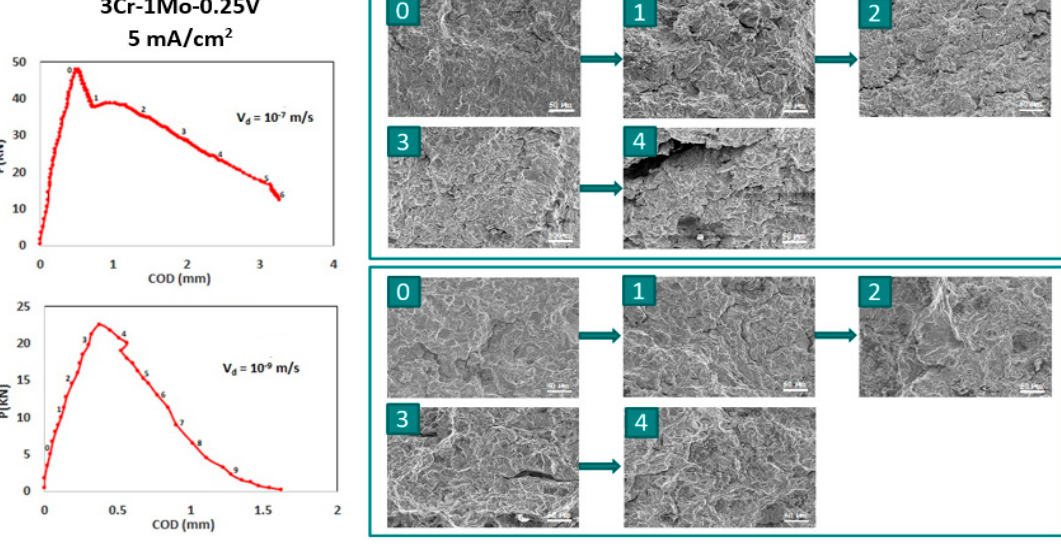
Figure 15. Fractographic images corresponding to different stages of P-COD register from the slow